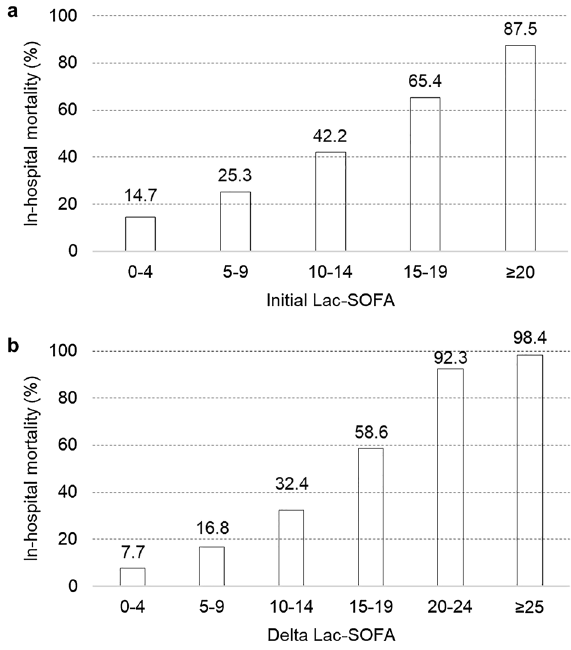
Figure 1. In-hospital mortality according to the changes in the initial Lac-SOFA score and Delta Lac-SOFA score. Patients were divided into five or six subgroups based on 5-point intervals of the ( a ) initial Lac-SOFA or ( b ) Delta Lac-SOFA scores. The numbers above the bar show the in-hospital mortality rate. ICU intensive care unit, SOFA Sequential Organ Failure Assessment score, Lac‑SOFA sum of the SOFA score and the Lac-score, Delta Lac‑SOFA sum of the Lac-SOFA ICU day-3 and Delta